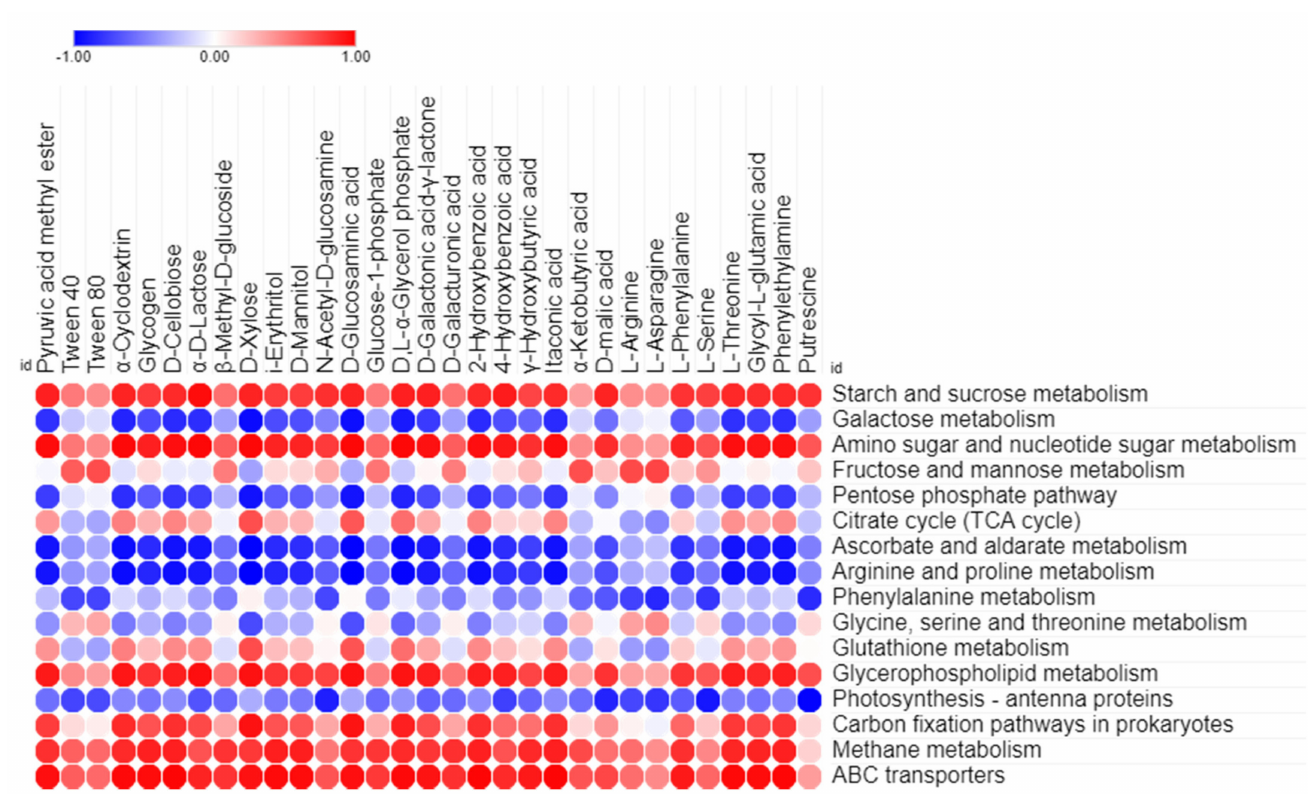
Figure 6. Visualization of Pearson’s correlation statistical test between 31 Biolog EcoPlate™ carbon sources utilization and related predicted functional KEGG pathway abundance of bacterial communities in all over the